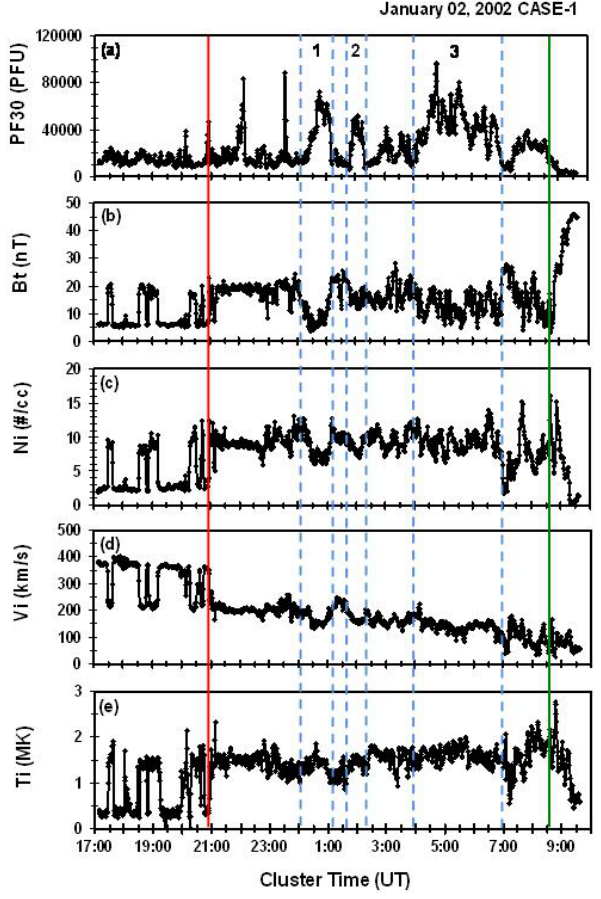
Fig. 4. Plot of particle flux (PF30), magnetic field strength, density, speed, and temperature data in the magnetosheath (from top to bot- tom) versus time for 2 January 2002. Red and green lines mark the bow shock, magnetopause and blue lines for the flux burst events studied.